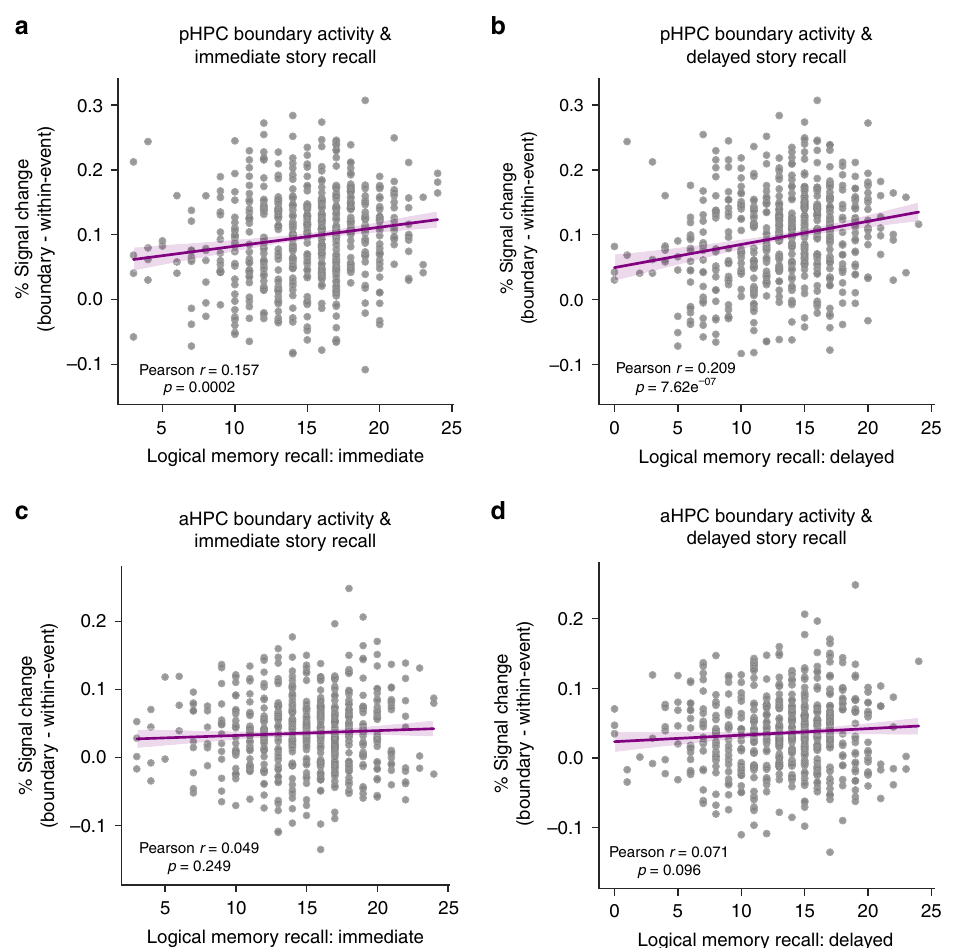
Fig. 3 Boundary-evoked activity and age-related decline in anterior and posterior hippocampus. pHPC activity at event boundaries signi fi cantly predicts memory for stories in immediate ( a ) and delayed ( b ) recall conditions. These relationships did not reach signi fi cance in aHPC ( c , d ) (correlations were assessed via Person ’ s r